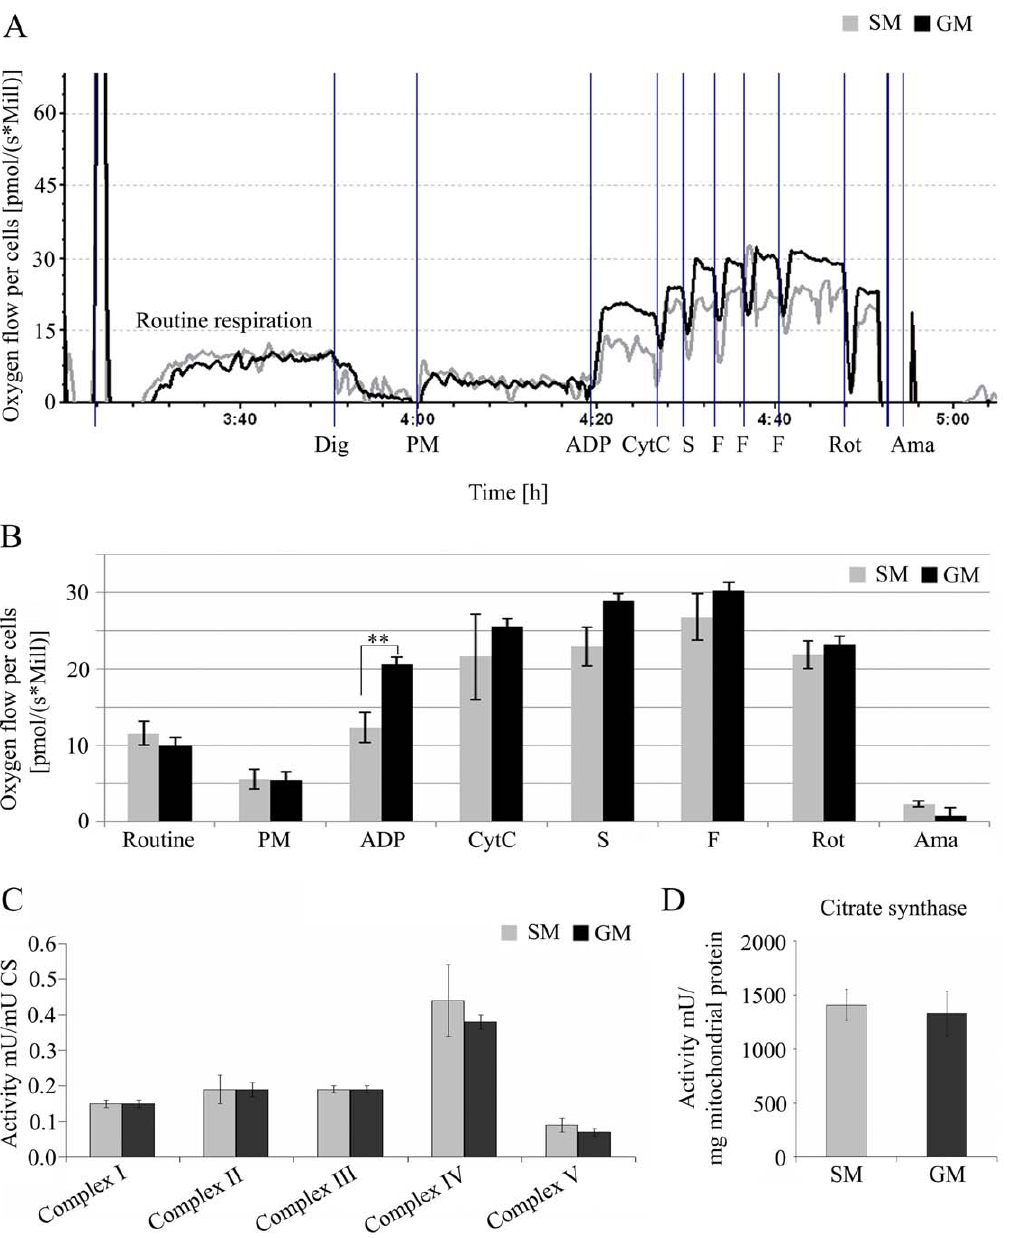
Figure 9. Energy state assessed by mitochondrial function in starved NCI-H295R cells. A,B. Oxygen consumption was assessed by high- resolution respirometry in digitonin-permeabilized NCI-H295R cells grown in growth medium (GM) versus starvation medium (SM). A, representative oxygraph traces. B, quantitative analysis of oxygen consumption is given as O 2 flow per cells in pmol/(s*Mill.). The addition of substrates, uncoupler and inhibitors is indicated on the x-axis. Routine: no addition (control); Dig: digitonin; ADP: adenosine diphosphate; PM: pyruvate and malate; CytC: cytochrome c; S: succinate; F: carbonyl cyanide p-trifluoromethoxyphenylhydrazone (FCCP); Rot: rotenone; Ama: antimycin A. Data represent means + / 2 SD, n=3. C,D. Spectrophotometric assays in isolated mitochondria. The specific activities of the respiratory chain complexes were obtained as mU per mg mitochondrial protein and are expressed as ratios to citrate synthase (CS) activity serving as quality control of equal mitochondrial content (D). Complex I (NADH:ubiquinone oxidoreductase), complex II (succinate dehydrogenase), complex III (ubiquinol-cytochrome c reductase), complex IV (cytochrome c oxidase), complex V (ATPase). Results are presented as mean of 2–3 independent experiments. Error bars represent + / 2 SD. **, P ,